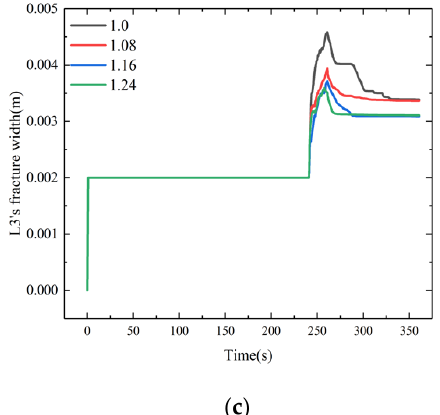
Figure 19. Variation curves of the fracture width in staged fracturing of CBM reservoirs under various values of the inhomogeneity coefficient of the in situ stress. ( a ) L1, ( b ) L2, ( c ) L3.